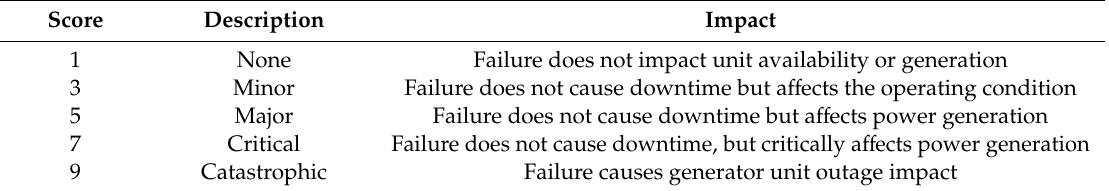
Table 3. System Availability Impact Scores and Description.